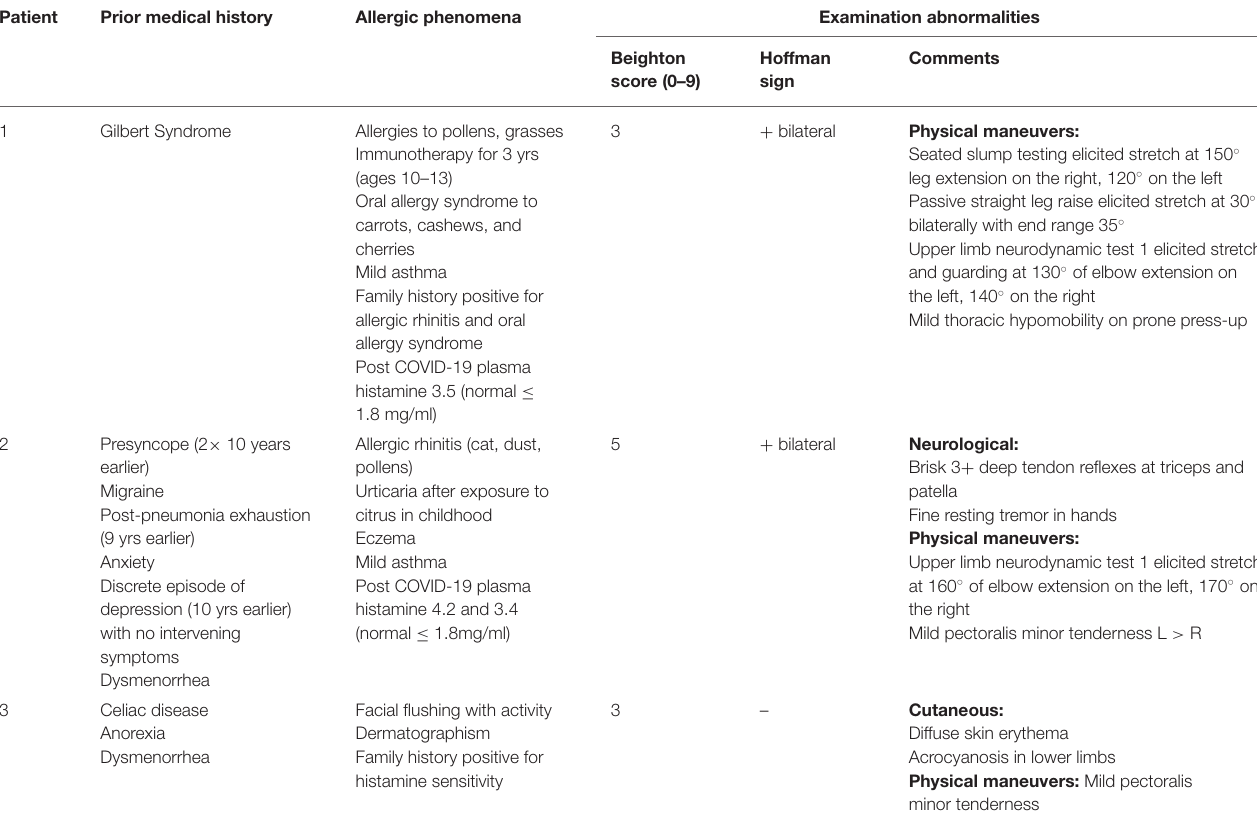
TABLE 3 | Past medical history and physical examination